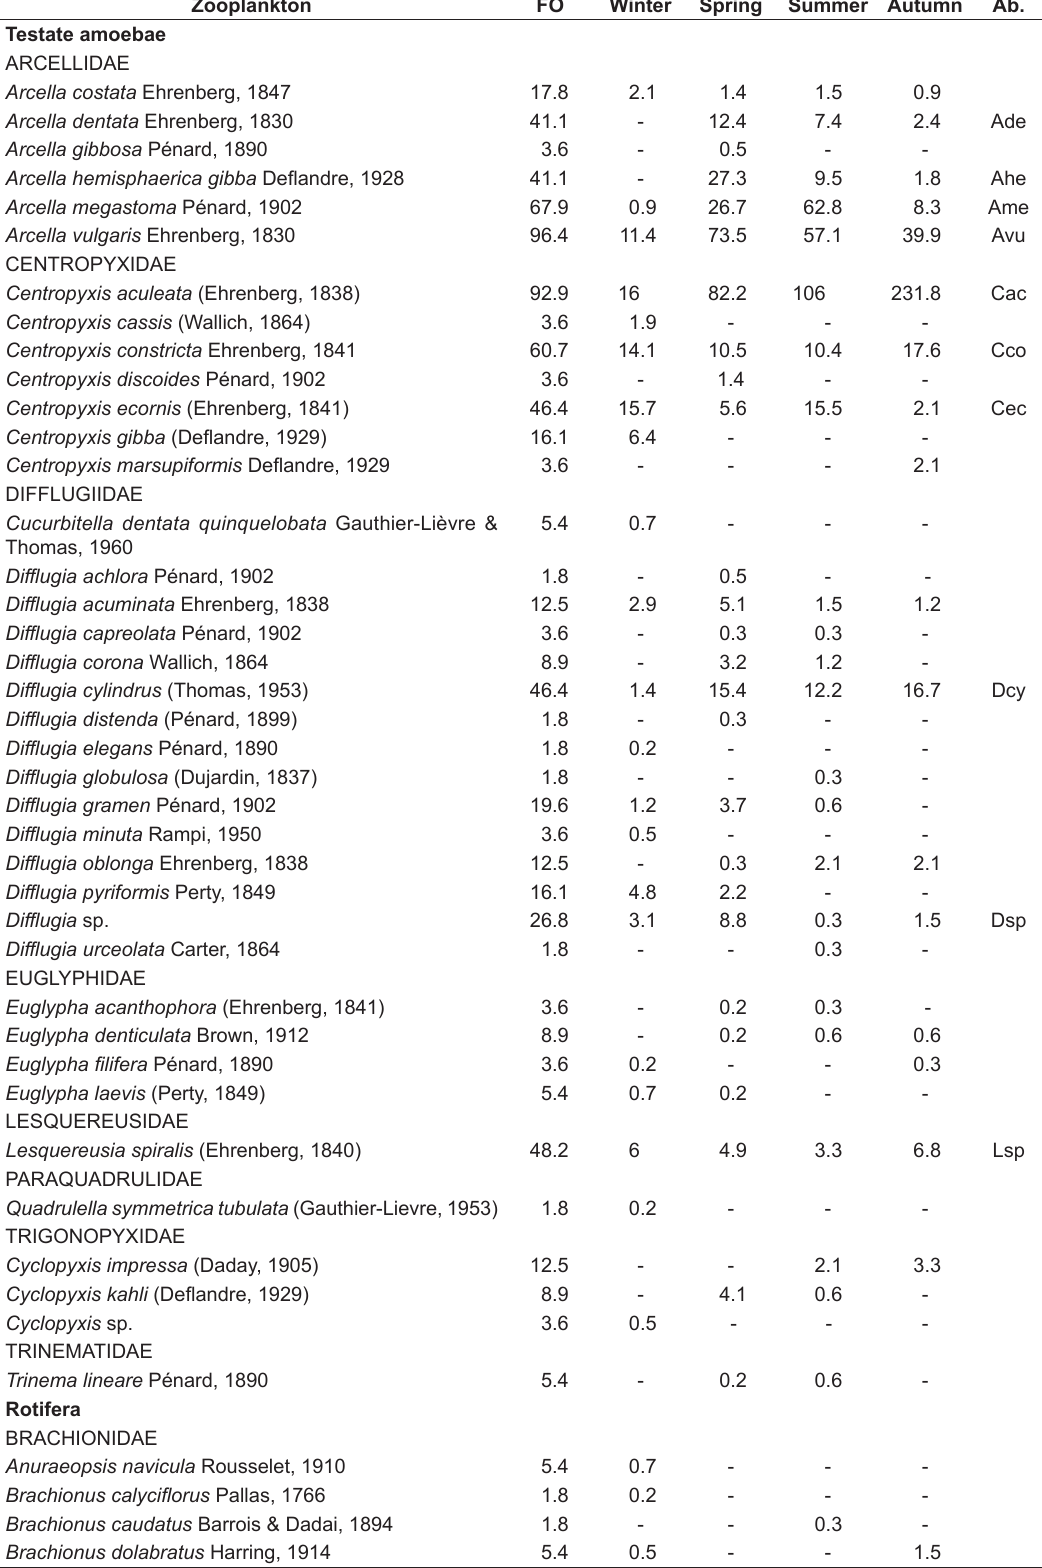
Table 3. Composition, frequency of occurrence (FO %) and mean abundance (ind. m -3 ) of zooplankton during the seasons in the Pelotas River sub-basin, with abbreviation (Ab.) of taxa used in CCA. Zooplankton FO Winter Spring Summer Autumn